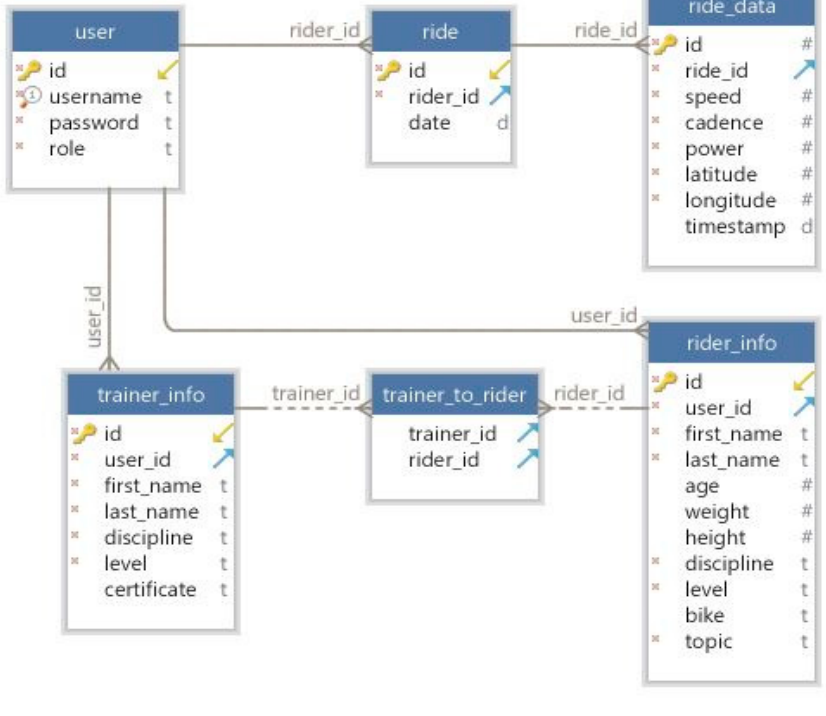
Figure 13. Database structure